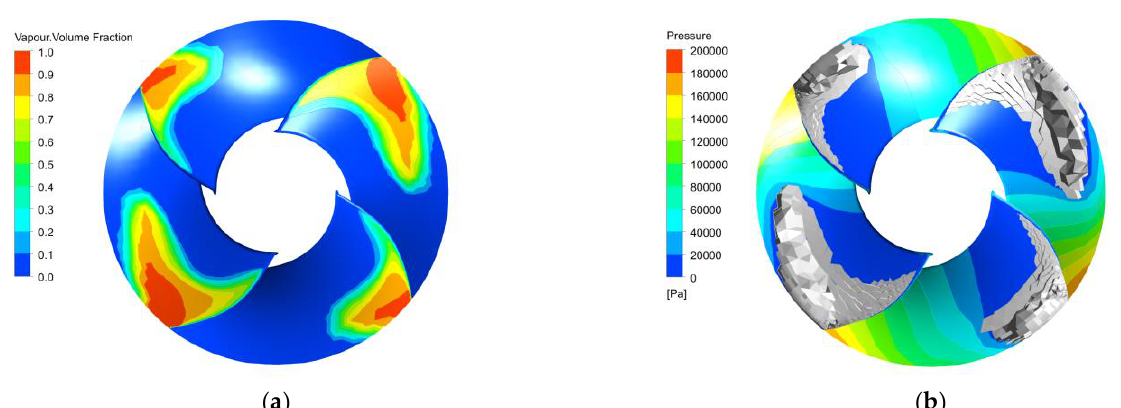
Figure 7. Visualization of CFD calculation results on the suction surface of rimless impeller № 2 ( Q = 0.3× Q BEP , NPSH = 3.65 m): ( a ) Vapor-filled cavities; ( b ) Isovolume of vapor with a concentration of more than 10%.